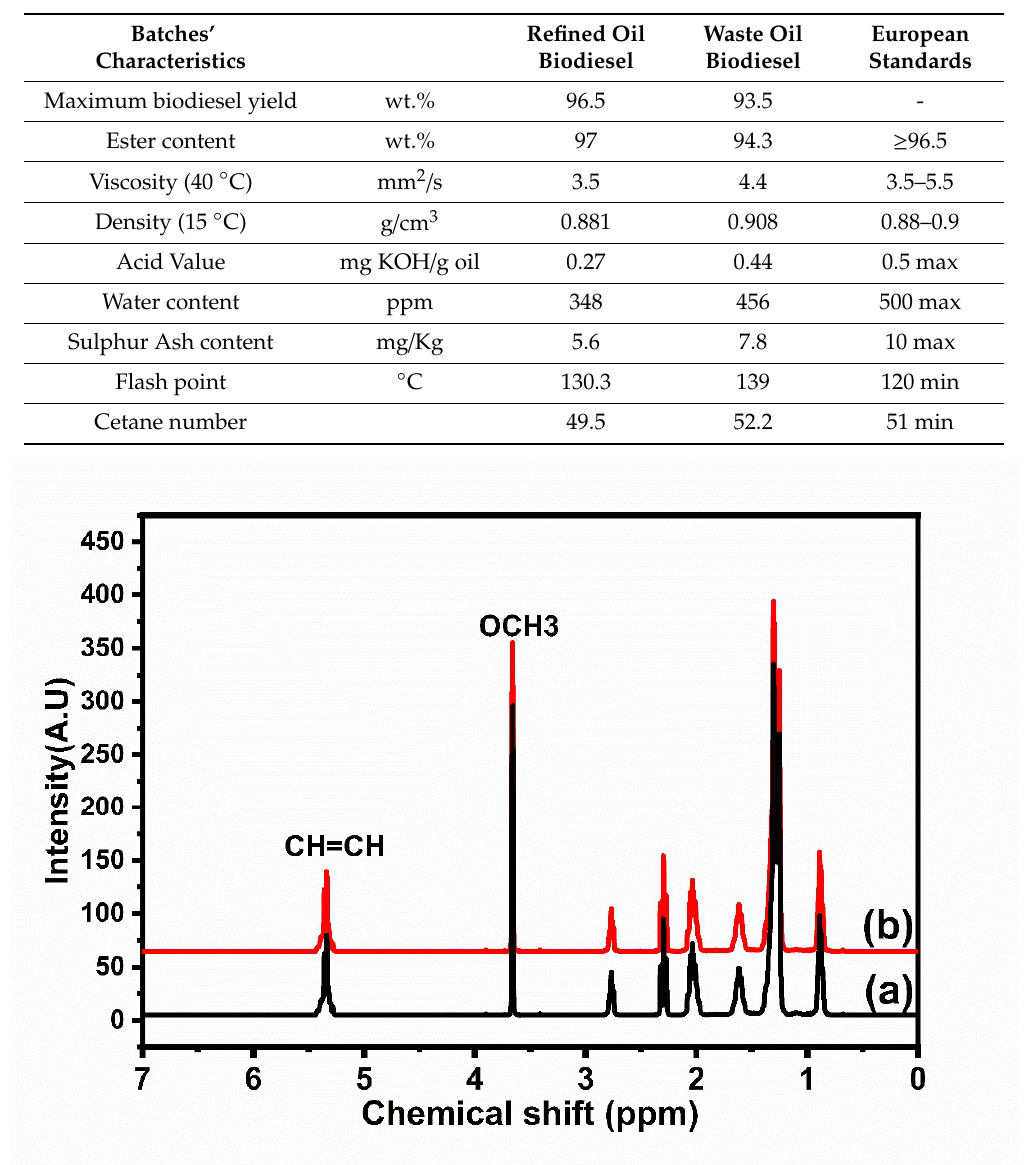
Figure 12. 1 H-NMR spectrum of biodiesel obtained with ( a ) refined cooking oil and ( b ) waste cooking oil.